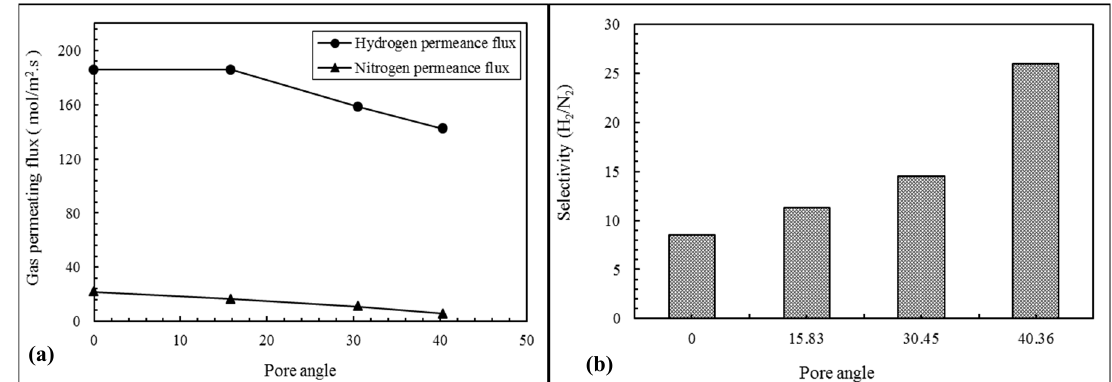
Figure 3. ( a ) Permeate flux of the hydrogen and nitrogen permeate fluxes (mol/m 2 ·s) for various pore angles; ( b ) selectivity H 2 /N 2 for various pore angles.